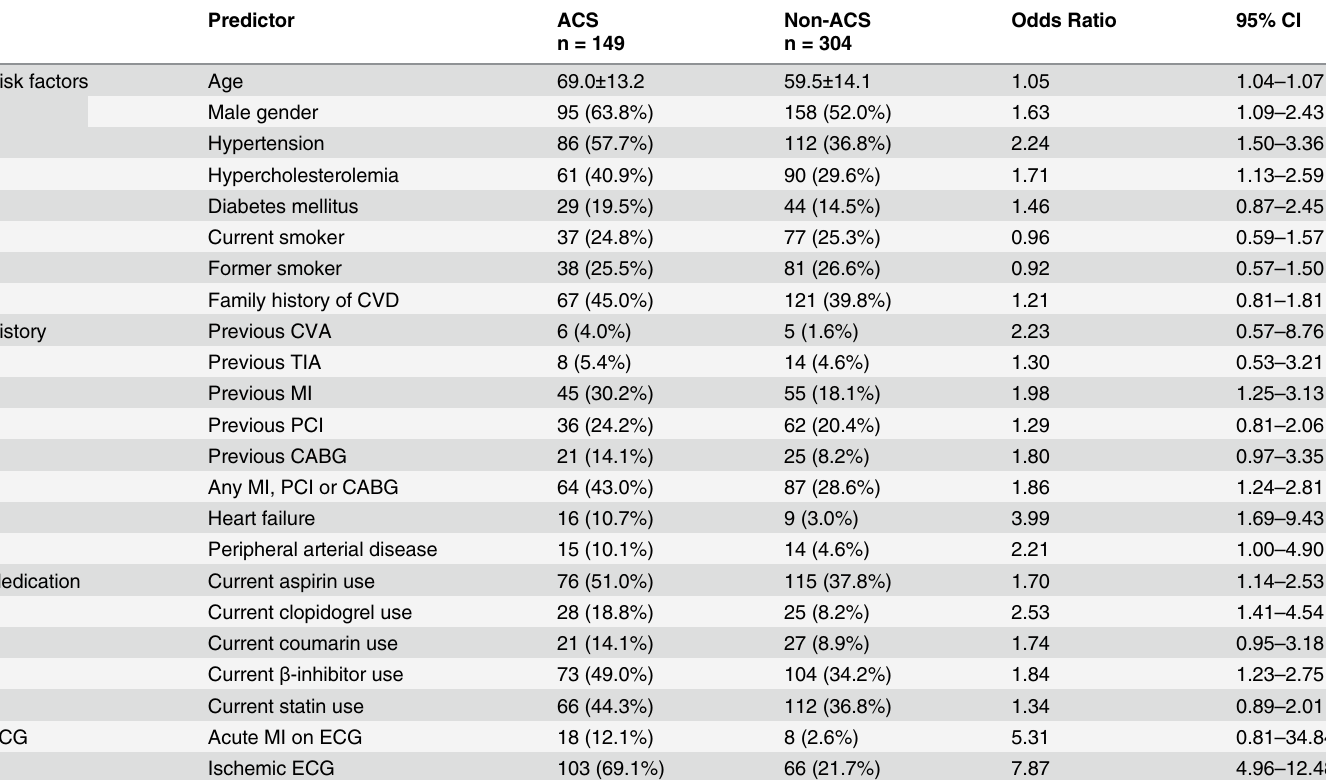
Table 5. Univariable analysis of possible predictors.